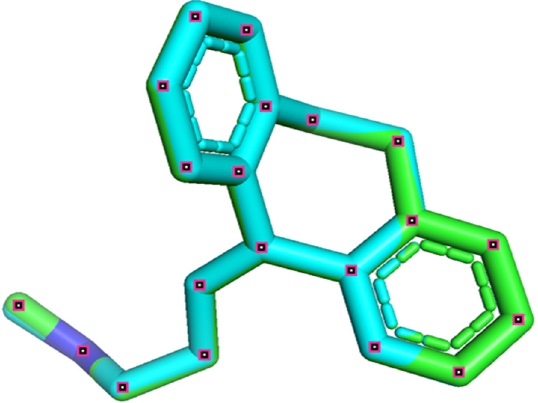
Figure 9. Re-docking pose with RMSD equal to 0.022 Å (original nortriptyline of cyan color, and docked nortriptyline of green color).